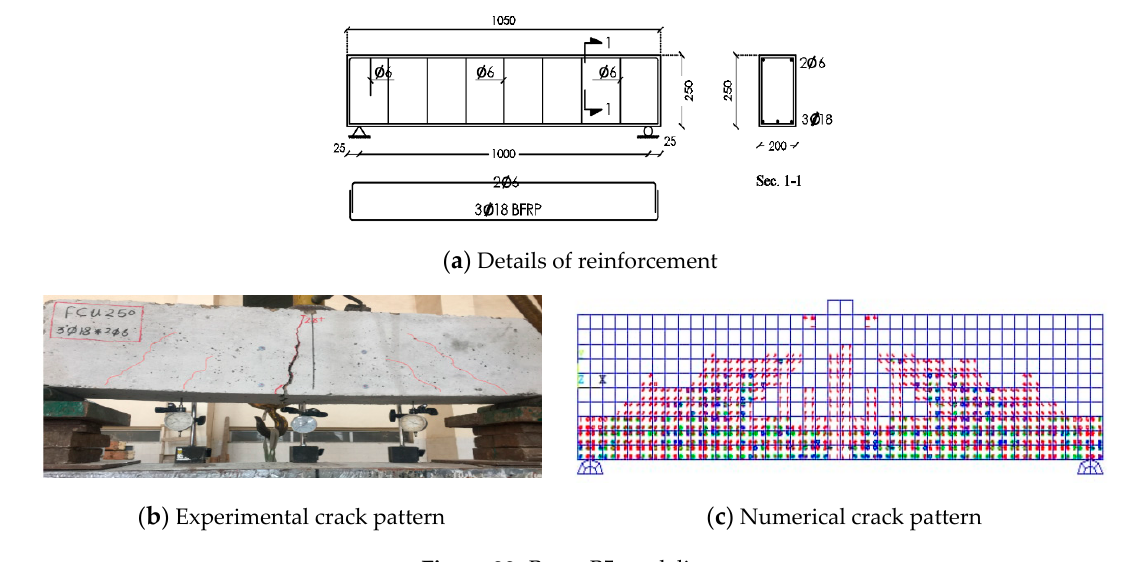
Figure 20. Beam B5 modeling.